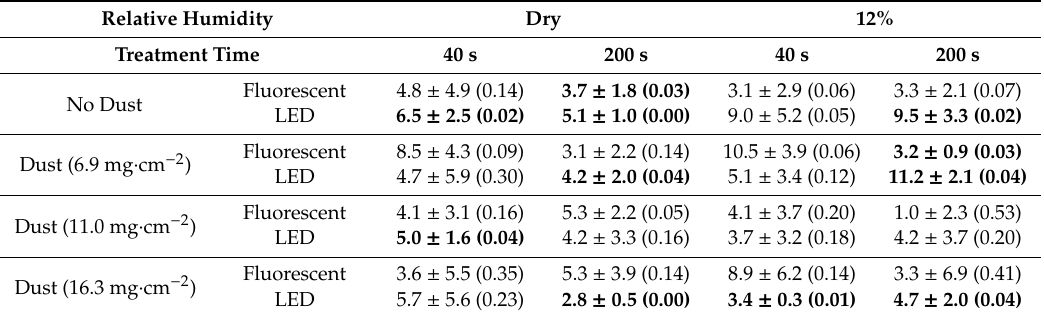
Table A9. N 2 O mitigation under the di ff erent dust levels at a relative humidity of dry and 12% in photocatalysis. Values in the table report % reduction ± standard deviation ( p -value) and are an average between treatments of NH 3 and H 2 S standard gases. Bold font signifies statistical significance.